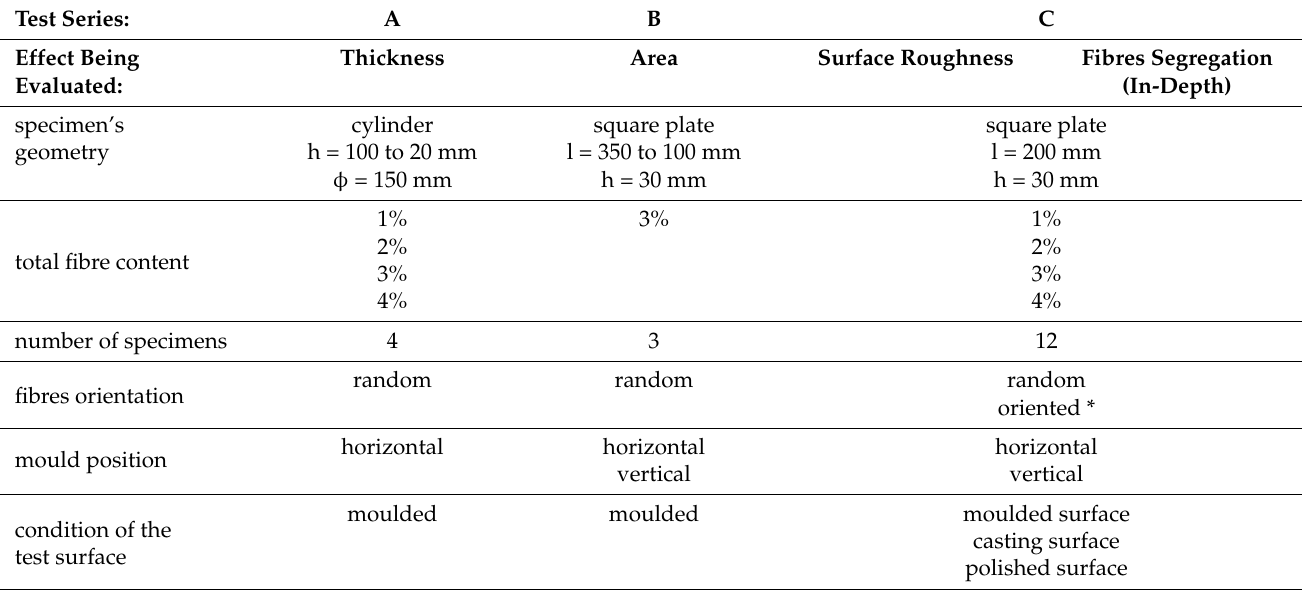
Table 3. NDT testing